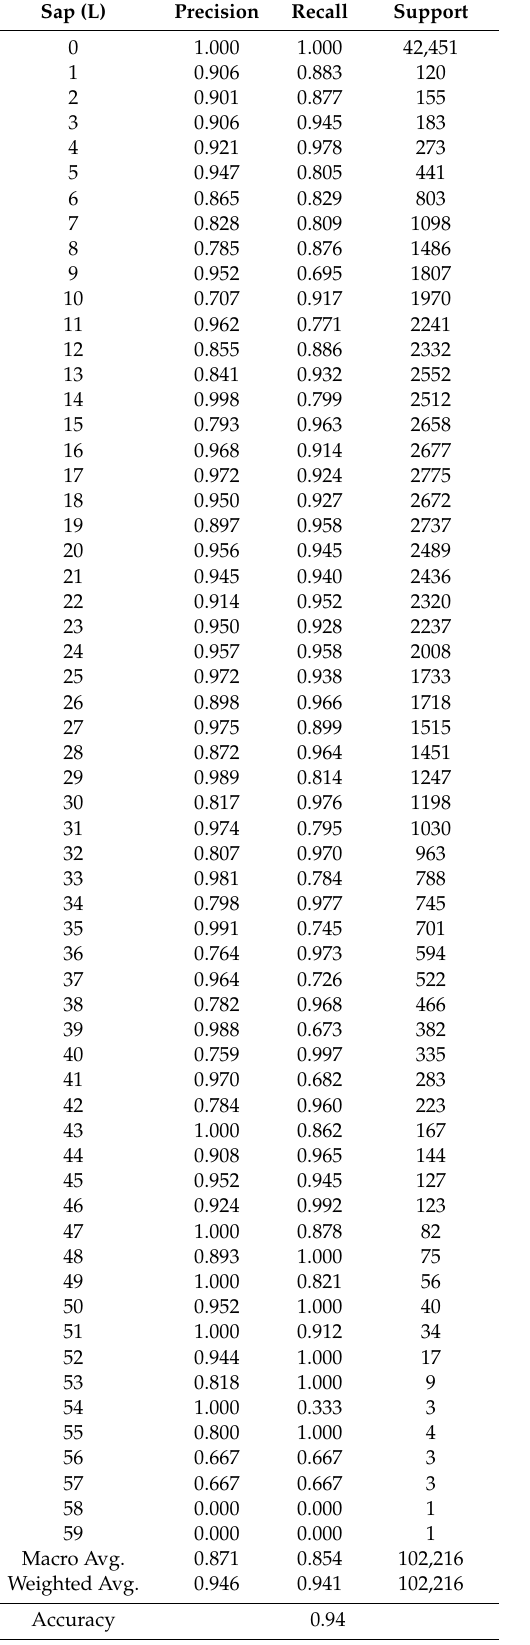
Table 9. Prediction accuracy of ANN optimal